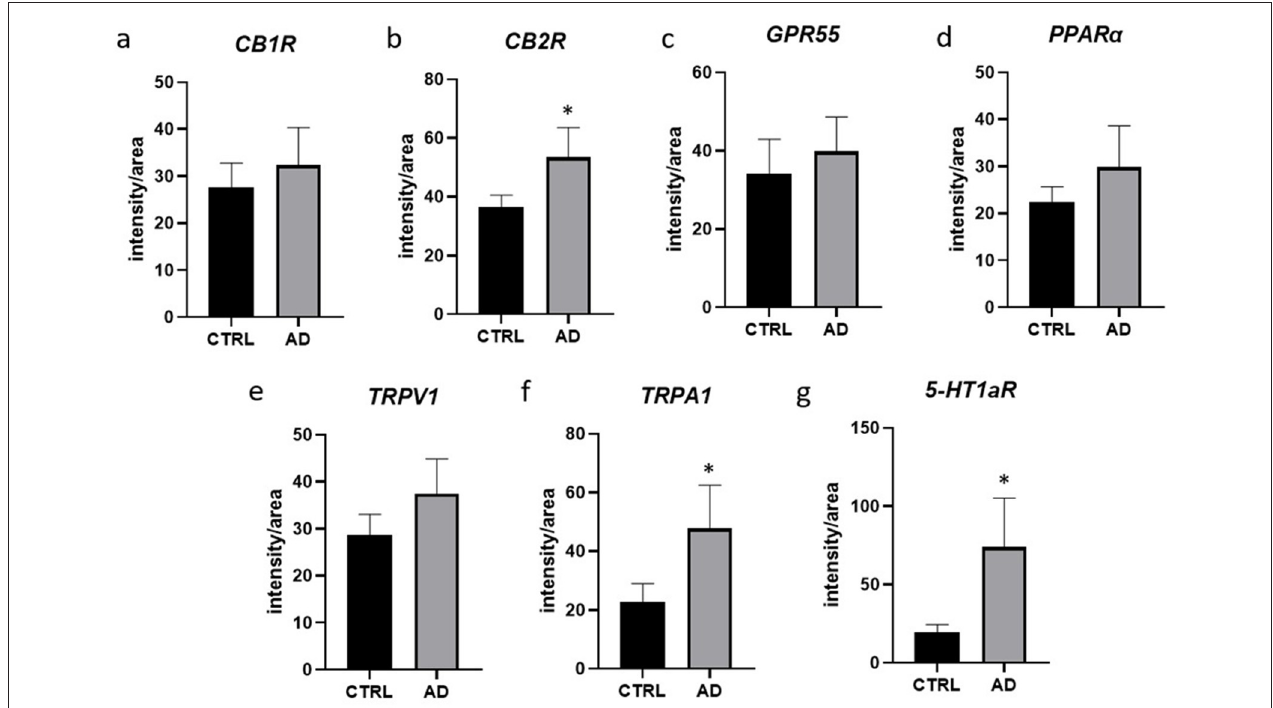
FIGURE 8 | Quantification of the intensity of the expression of CB1R (a) , CB2R (b) , GPR55 (c) , PPAR α (d) , TRPV1 (e) , TRPA1 (f) , 5-HT1aR (g) , in the suprabasal layers of 7 CTRL- and 8 AD-dogs. Data are represented as Mean ± SD and were analyzed using the Student T -test. P < 0.0071